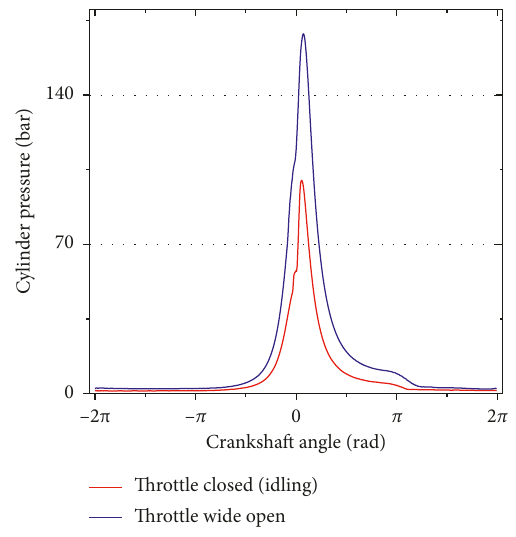
Figure 5: Engine cylinder pressure.